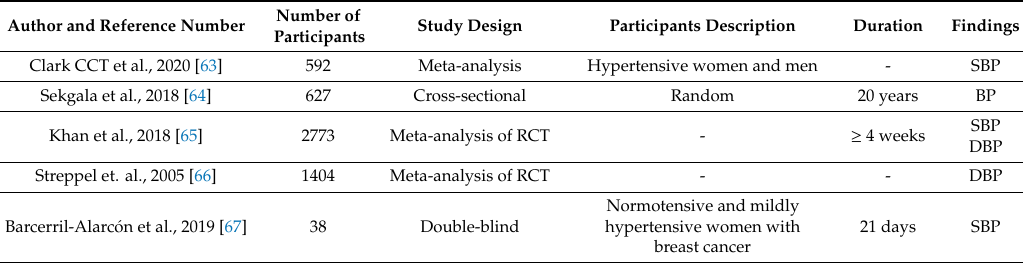
Table 5. Comparison of